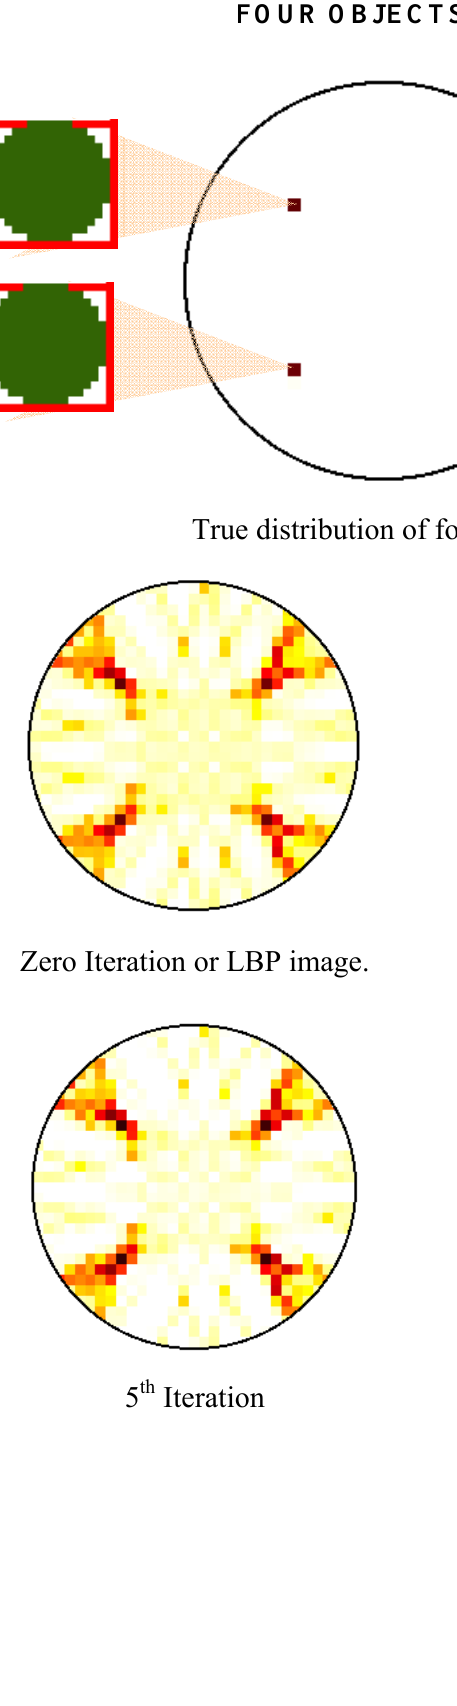
Figure 8. Tomogram results for four objects flow